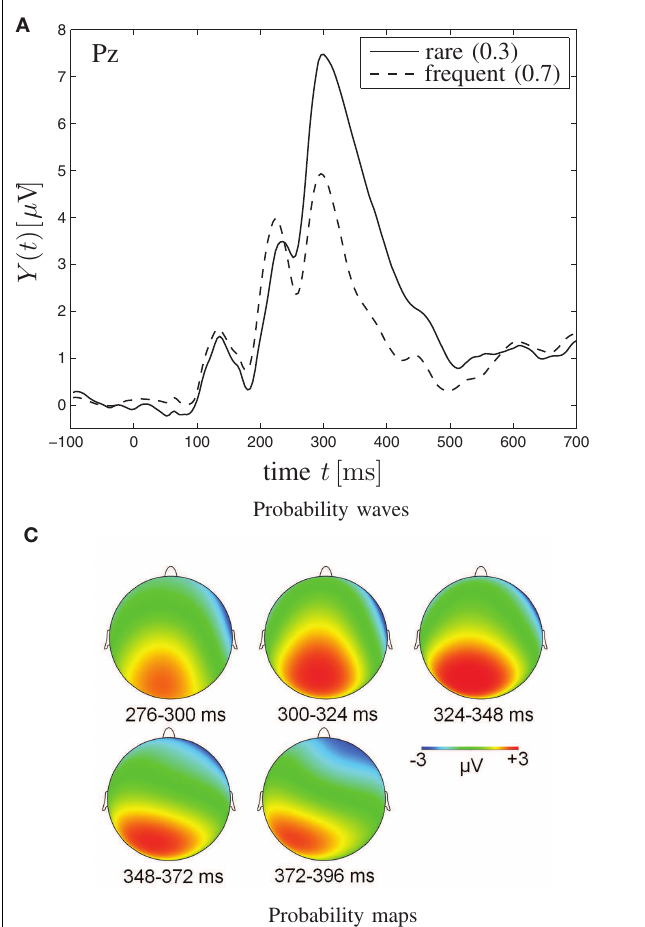
amplitudes. Specifically, for the single - b - sequence abaa , the P300 waveform lies amongst those from dual - bb - sequences, whereas for the dual - bb - sequence baba , the P300 waveform appears indistinguishable from the waveforms from single - b - sequences. As further detailed in the Discussion, this amplitude reversal is attributed to the disconfirmation of alternation expectation in the abaa sequence, was well as to the confirmation of alternation expectation in the baba sequence. (D) Sequence maps show the scalp topography of the bbba - aaaa difference wave in the [0.5, 0.5] probability category at various points in time (292–412ms, divided into five time windows of 24ms